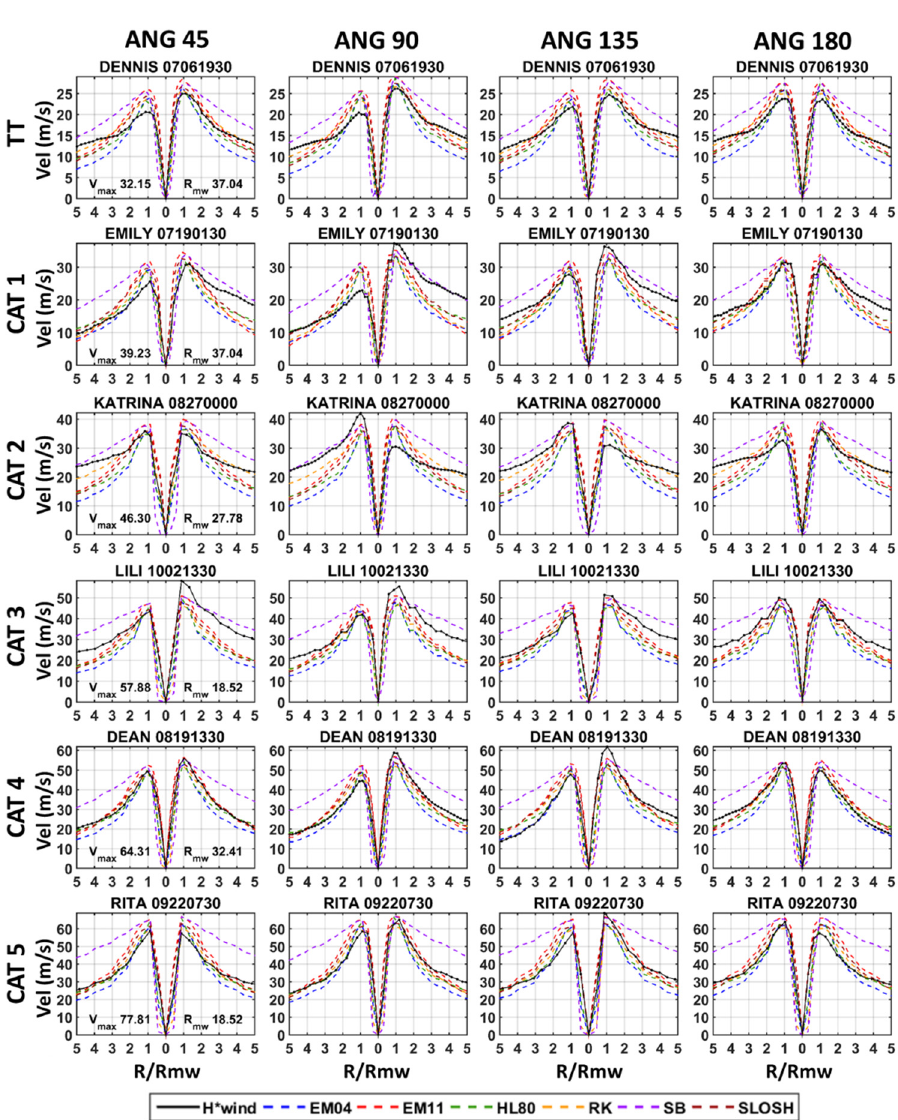
Figure 3. Subset of radial wind profiles as a function of normalized distance by r/R mw from H*Wind and parametric models, for TC in categories 1–5, at 45 ° , 90 ° , 135 ° and 180 ° taken as reference the track direction. Subplot title includes TC name and date (month, day, hour, and minute).